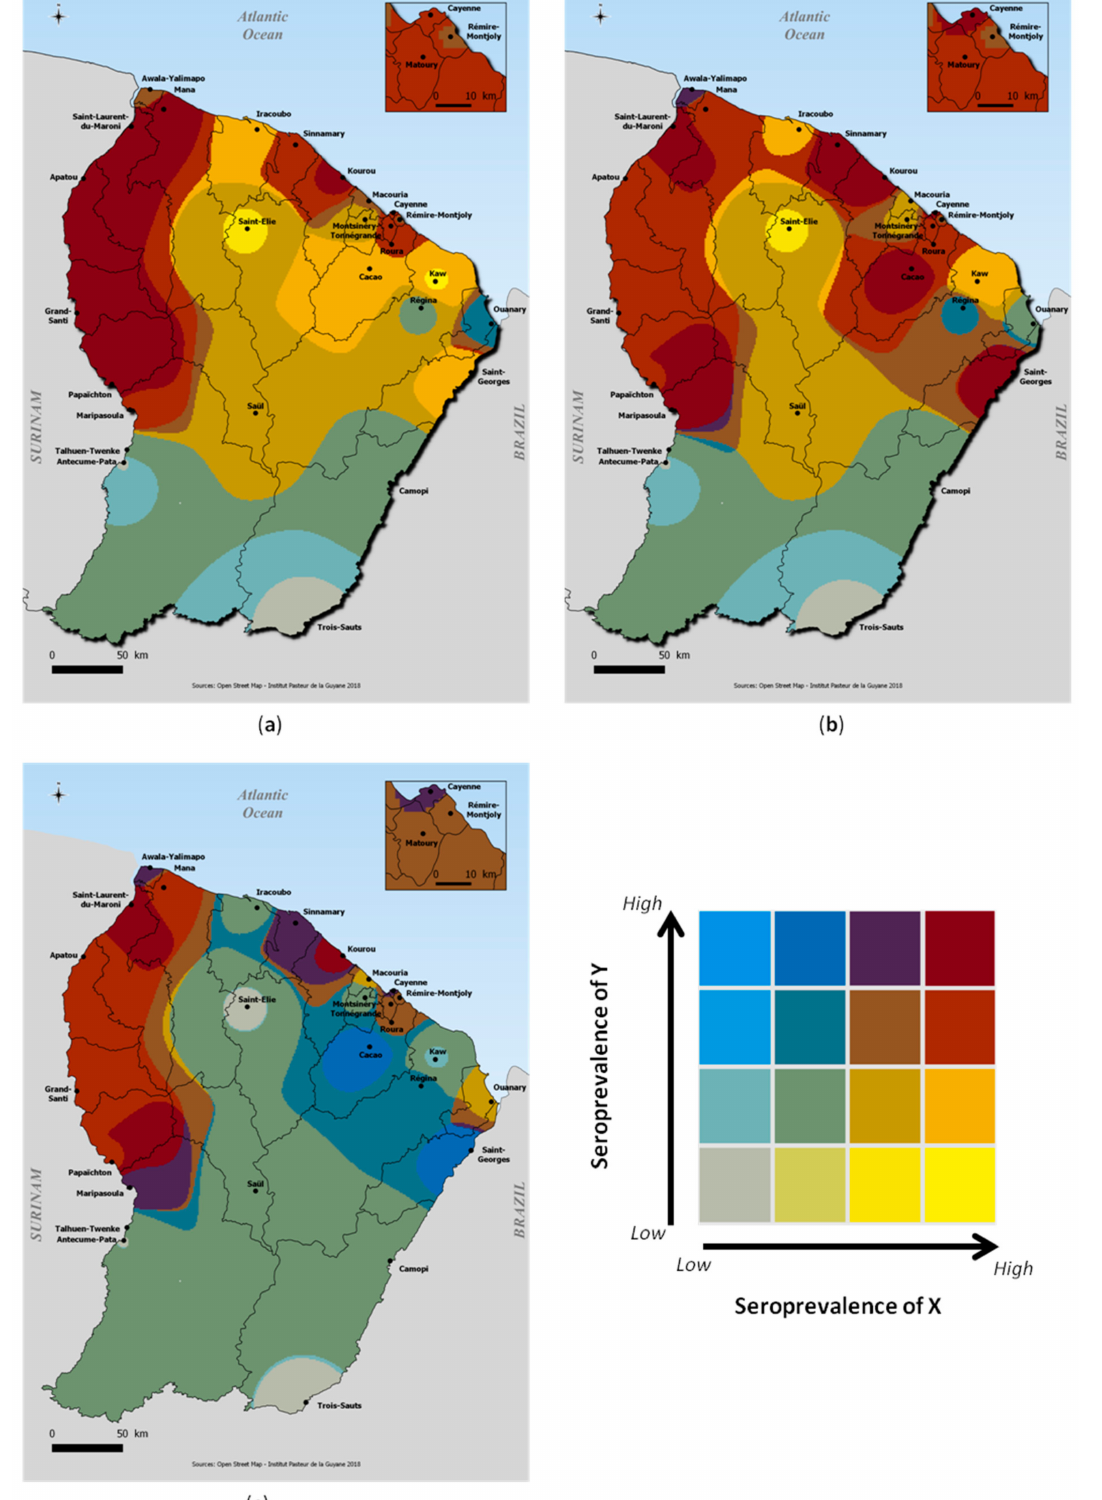
Figure 4. Graphical representation of the correlations between DENV, CHIKV and ZIKV seroprevalences levels; ( a ) DENV (X) vs. CHIKV (Y); ( b ) DENV (X) vs. ZIKV (Y); ( c ) CHIKV (X) vs. ZIKV seroprevalence